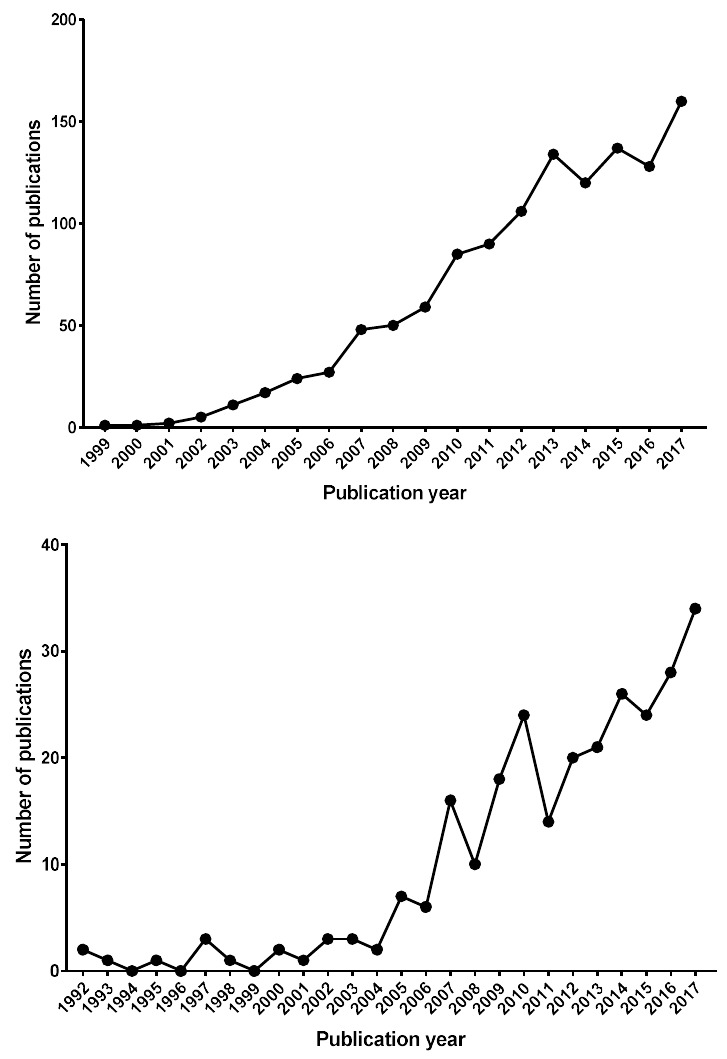
Figure 3. Trends in all articles published on Bd ( top ) and Rv ( bottom ) in the literature over time. Publications were compiled using the search strings “ Batrachochytrium dendrobatidis + amphibians” and “ ranavirus and amphibians” in the Web of Science database, from which duplicates and articles that were unrelated were removed. The Bd search yielded a total of 1207 hits and the Rv search yielded 269